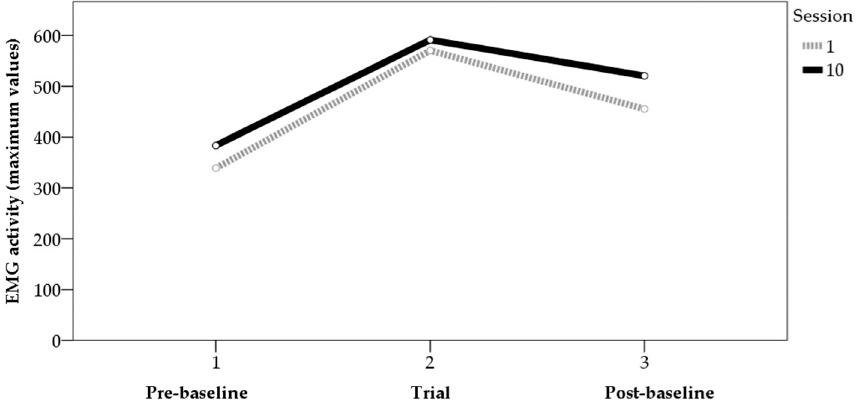
Figure 1. EMG activity (maximum values) pre-baseline, trial, and post-baseline (sessions 1 and 10).